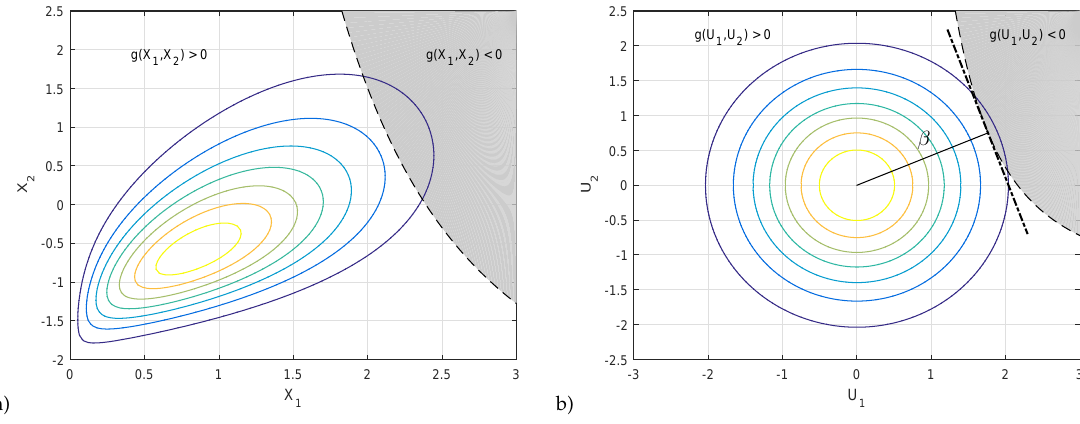
Figure 1b. In conclusion, the probability of failure is given by p f = 1 − Φ ( β ) .